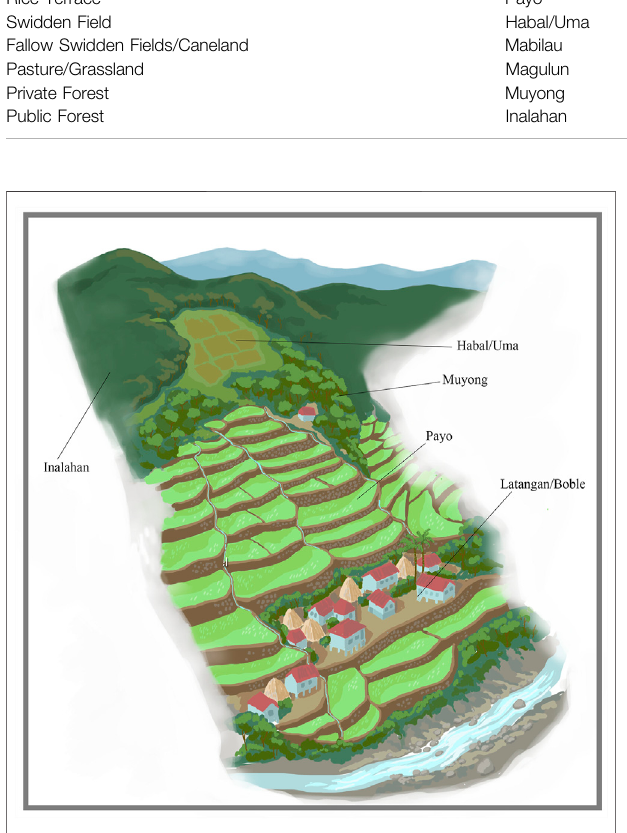
FIGURE 2 | A drawing of OKV and its associated land use, with labels. The forms of land use are arranged as they exist in 20th and 21st century Ifugao